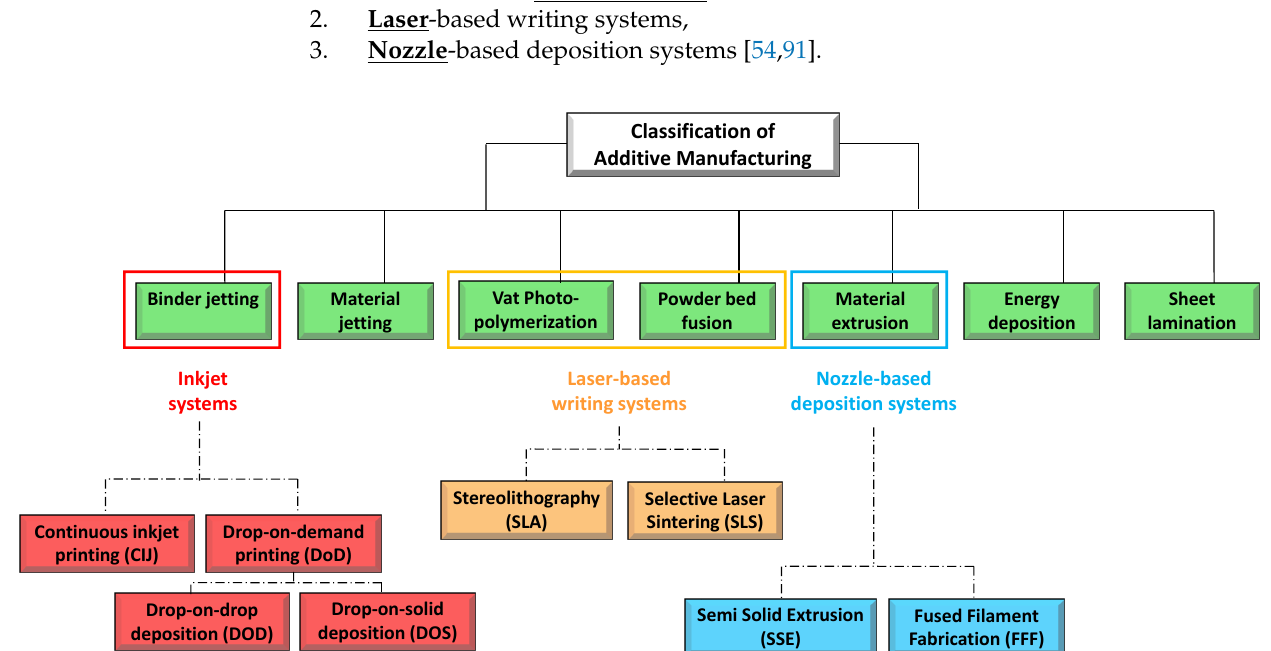
Figure 7. Schematic view of additive manufacturing processes according to ISO/ASTM 52,900:2021 classification [89,90], with in evidence the main AM methods applied in pharmaceutical and biomedical field [54,91].